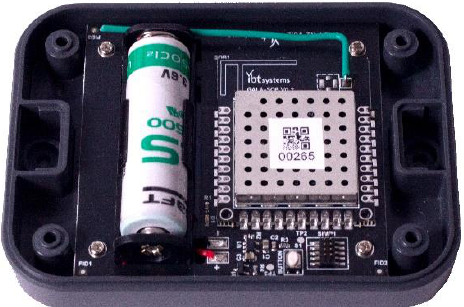
Figure 1. Picture showing the internal section of the sensor node.